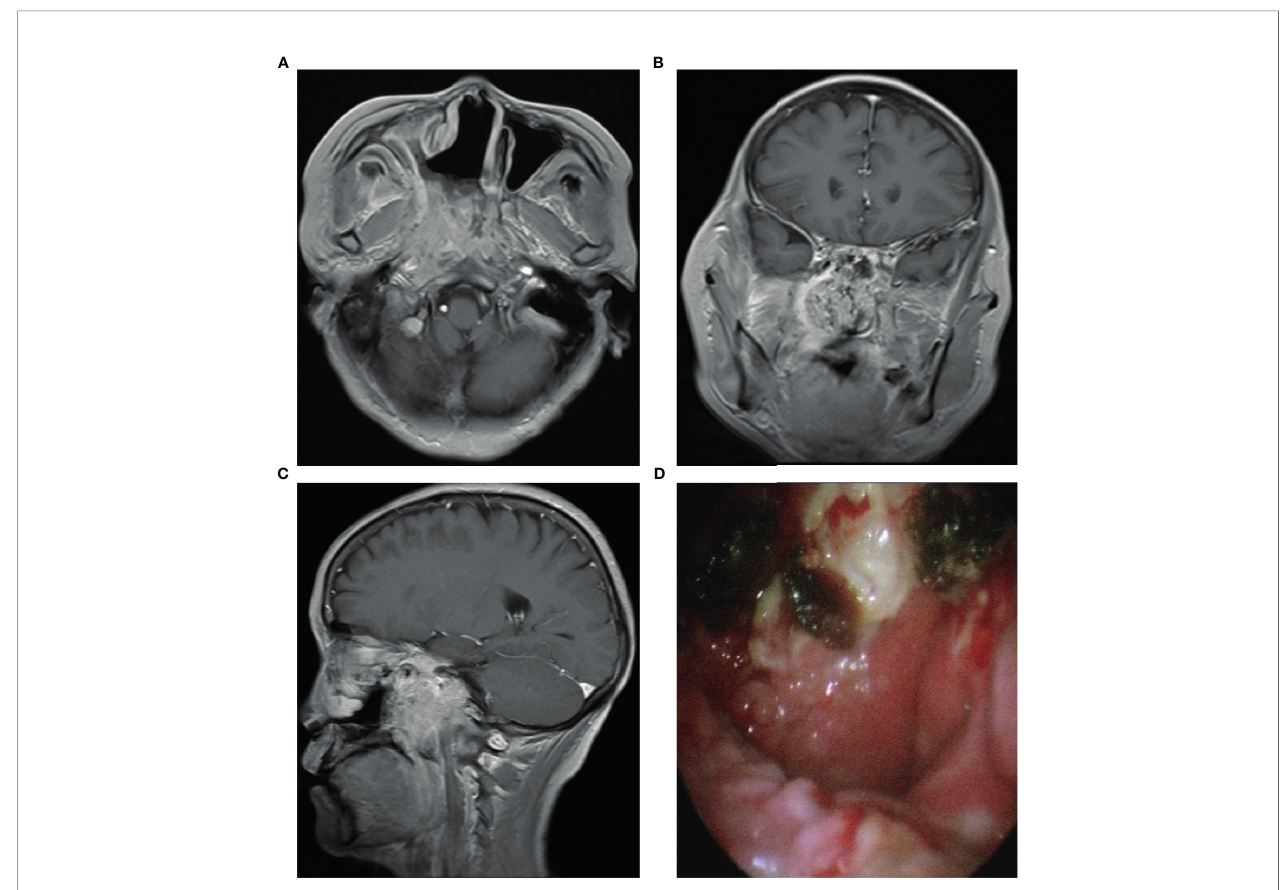
FIGURE 1 | Contrast enhancement T1-weighted MR imaging showed that the tumor invaded the parapharyngeal space and nasopharynx (A – C) ; (D) Electronic nasopharyngoscope showed new organization in the